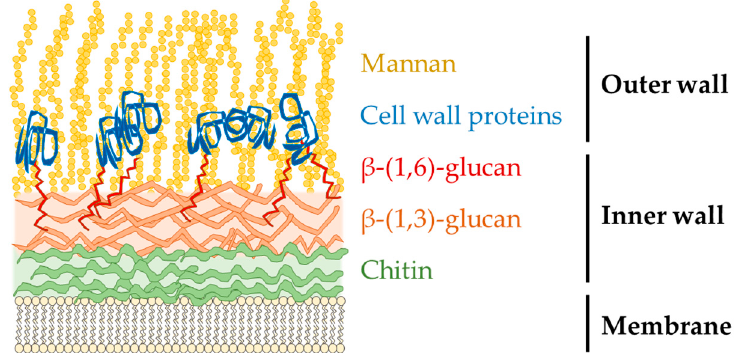
Figure 2. Candida albicans cell wall structures in yeast and hyphal forms have similar composition. However, chitin in the inner wall of hyphae is at least three times thicker than in yeast, and the amount of mannose in the mannan of yeast is higher than in that of hyphae [19,20].